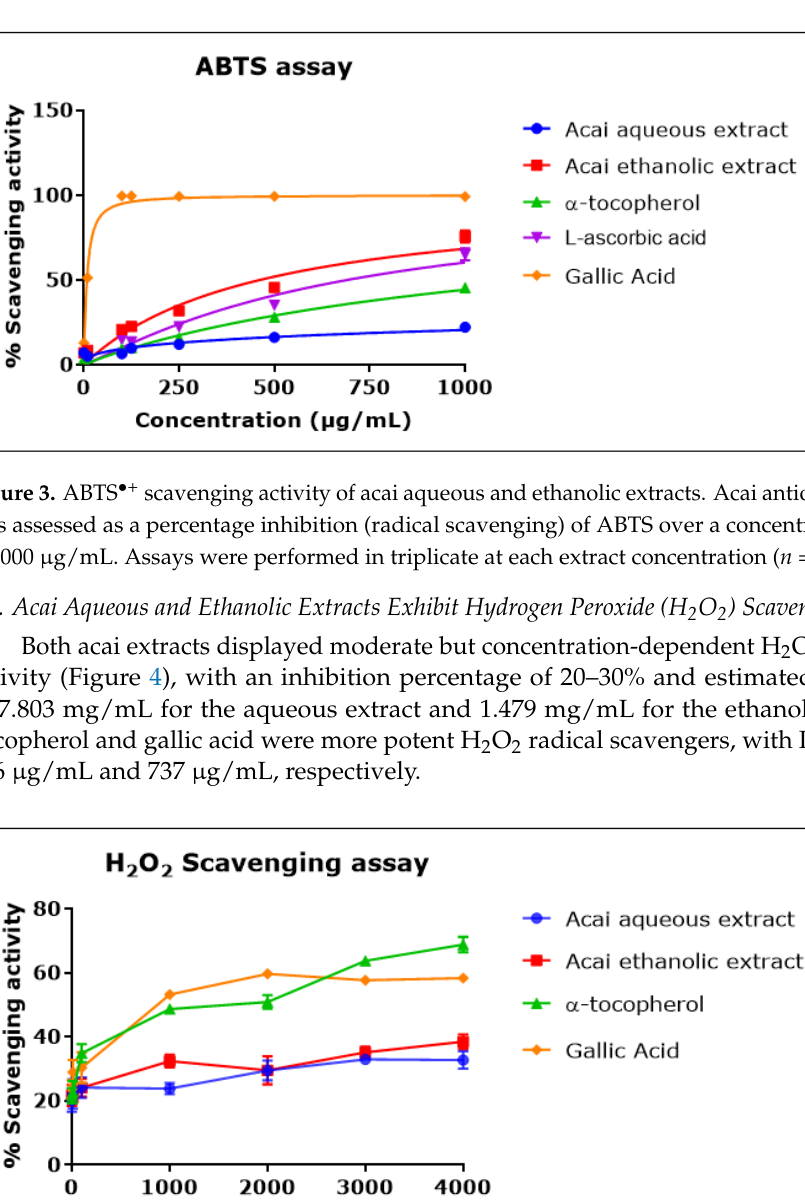
Figure 4. H 2 O 2 scavenging activity of acai aqueous and ethanolic extracts. Acai antioxidant activity